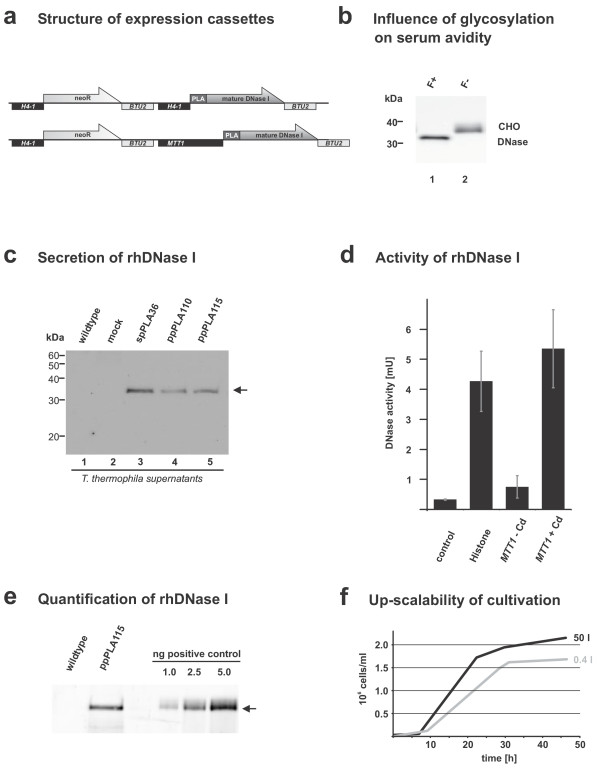
Expression of functional human DNaseI. a: The structure concept of the expression cassettes. For all expression cassettes we used the cell-cycle dependent H4-1 histone or the Cd-inducible MTT1 promotor and the beta tubulin 2 (BTU2) terminator sequence. Selection was done by the neo resistance gene (neoR). Secretion of the rhDNase was regulated by parts of the endogenous precursor of PLA1. We used the first 36, 110 and 115 amino acids of the PLA-precursor. The mature human DNase I corresponds to the aa 23–281. b: We obtained an anti DNaseI serum by using CHO derived DNase I (Pulmozyme) as an antigen. After that the serum was tested by western blot using de-glycosylated DNaseI (PNGaseF treated, F+ lane1) as well as the glycosylated protein. No significant difference in the signal strength could be observed, suggesting that the N-glycan structure of rhDNase has no, or only a minor influence on the avidity of the serum. c: Secretion of processed recombinant human DNaseI into the media. Lane1: 20 μl supernatant of the T. thermophila wildtype strain B1868.7, negative control; Lane2: 20 μl supernatant of mock-(EGFP) transformed T. thermophila; Lane 3–5: 20 μl supernatant of T. thermophila cells that were transformed with expression plasmids, carrying the spPLA36, ppPLA110 and ppPLA115 prepro-peptides, respectively. d: Determination of DNase activity in 10 μl supernatant of transformed T. thermophila. Control: mock-(EGFP) expressing cells; Histone: cell cycle dependent expression of ppPLA115; MTT1: inducible expression of ppPLA115; (MTT1-Cd: non-induced; MTT1 + Cd: induced). e: Different amounts of rhDNaseI from CHO cells (1.0, 2.5 and 5.0 ng) were used to roughly quantify the yield of rhDNase in 30 μl ppPLA115 supernatant of T. thermophila. f: Demonstration of up-scalability by comparing cell titres during 50 litre fermentation (black) and 400 ml shaker flask cultivation (gray) of rhDNase I secreting T. thermophila.